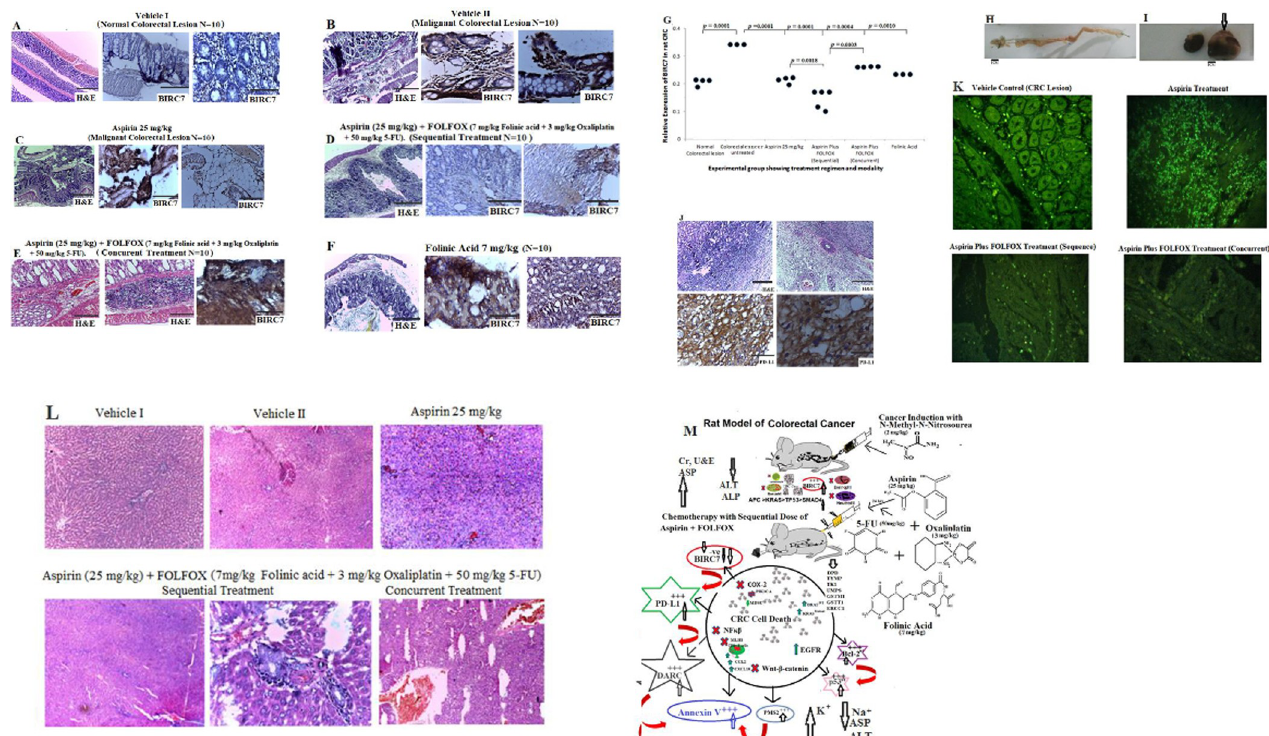
Fig 5. The treatment effect of aspirin with or without FOLFOX on apoptotic cell death in colorectal cancer in vivo in rat (scale bar = 50 μ m for H&E and scale bar = 100 μ m for IHC). A—F show various pattern of BIRC7/Livin expression in aspirin with or without FOLFOX treated rats and also in untreated group. G shows relative expression of the BIRC7 in rats typified in dot plot. H CRC-bearing rats treated with oxaliplatin showing obstructed colonic lumen devoid of faecal material. I show an enlarged abnormal Kidney (arrowed) from the oxaliplatin-treated rat observed during the post mortem. J Sections of enlarged kidney showing features of renal cell carcinoma with sarcomatoid differentiation with positive expression of PD-L1. K Sections showing different IF staining pattern upon treatment with aspirin only and aspirin plus FOLFOX in sequence and concurrent. L Sections of the liver showing preserved architecture that is devoid of haemorrhage in the group of rats treated with aspirin plus FOLFOX in sequence compared with concurrent treatment. M describes the possible pathways of the effect of sequential treatment of aspirin plus FOLFOX during tumour induction and chemotherapy. Several pathways are responsible for the aspirin and FOLFOX drug metabolism, transport and target mechanisms and they include but not limited to: COX2 inhibition, NFkB and Wnt- B-Catenin signalling pathways for aspirin; dihydropyrimidine dehydrogenase (DPD), thymidine phosphorylase (TYMP), thymidine kinase 1 (TK1) and uridine monophosphate synthetase (UMPS) for fluoropyrimidine component, 5-FU; and excision cross-complementing genes (ERCC) and glutathione S- transferases (GSTM) for the oxaliplatin (trans-1-diaminocyclohexane oxalateplatinum). These non-exhaustive have significant role in BIRC7, DARC, Annexin V, PD-L1, PMS2, EGFR, BRAF, KRAS, MDSC, PIK3CA, p53, BCL2 expression and functions. In NMU-induced colon carcinogenesis in rats, there is marked destruction of lymphocytes and granulocytes, significant reduction of red blood cells, platelet and total white blood cells. This was followed by reduction in alanine aminotransferase and alkaline phosphatase levels with increase in creatinine, electrolytes, urea, and aspartate aminotransferase levels. Sequential treatment of aspirin plus FOLFOX may confer a better anti-tumour immune response in CRC and this is justified by increase expression of PD-L, DARC and suppression of